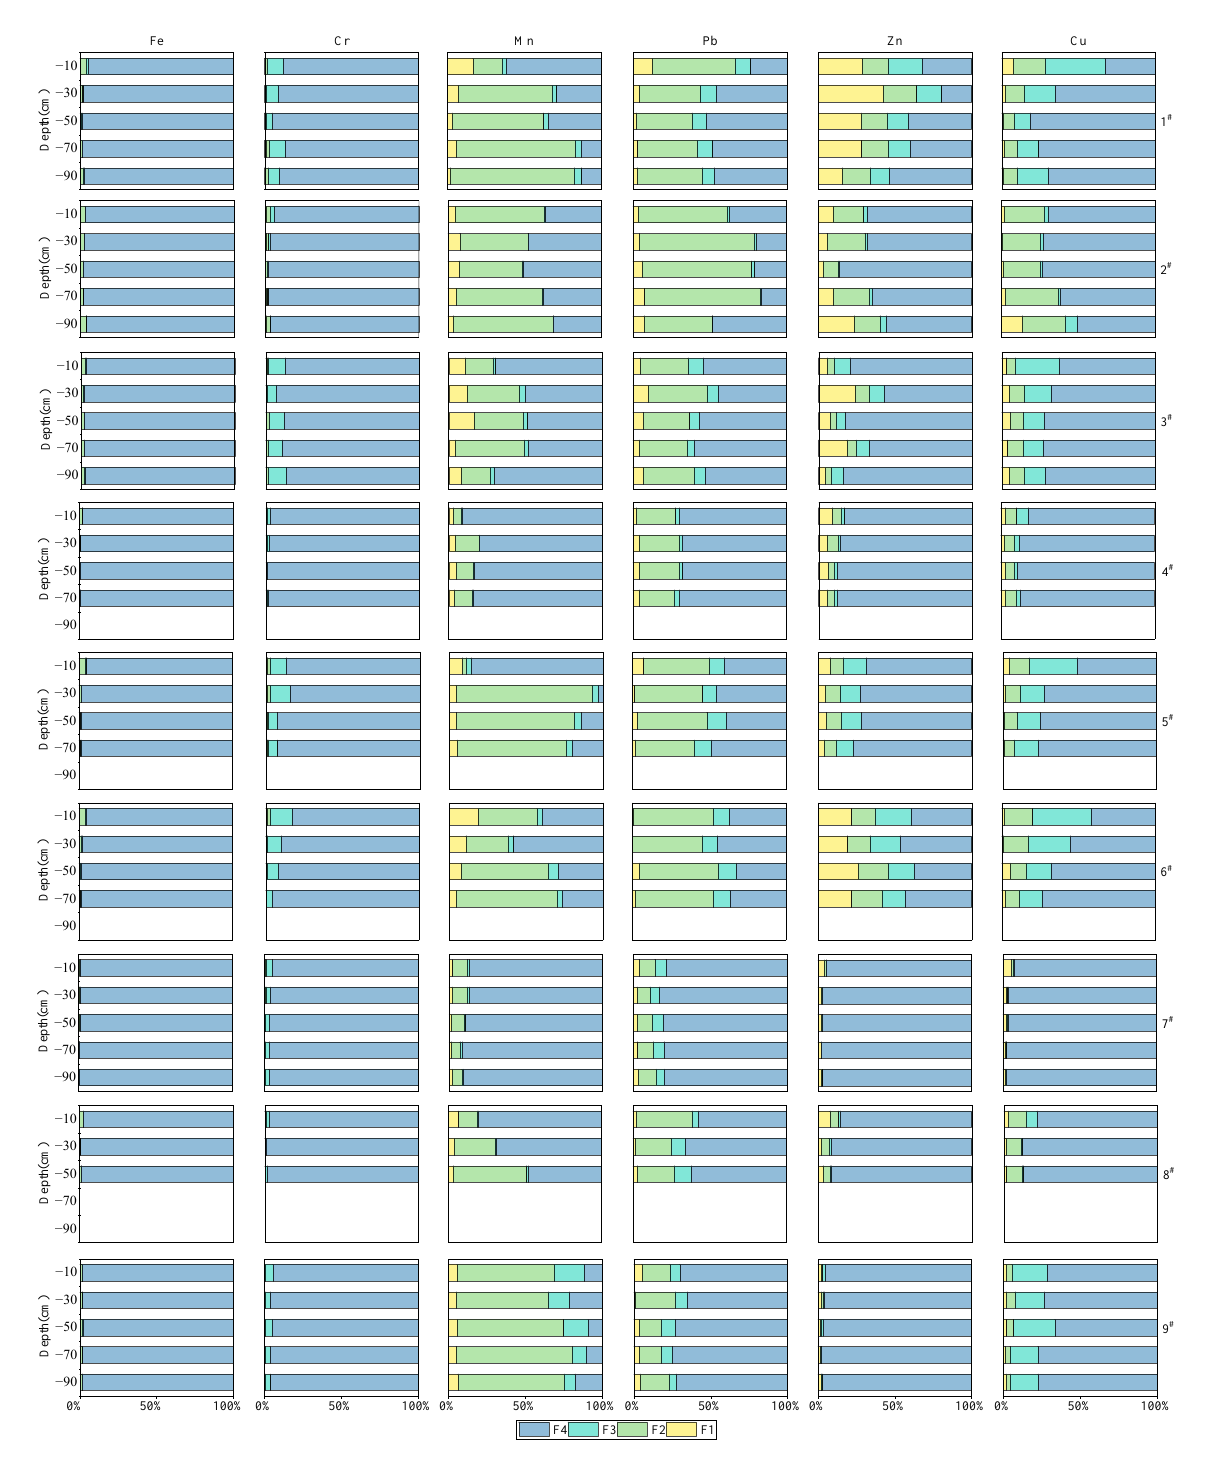
Figure 3. Distribution characteristics of HMs in sampling points. (Note: F1: ratio of weak acid extractable fraction heavy metal to total heavy metal; F2: ratio of reducible fraction heavy metal to total heavy metal; F3: ratio of oxidizable fraction heavy metal to total heavy metal; F4: ratio of residual fraction heavy metal to total heavy metal).